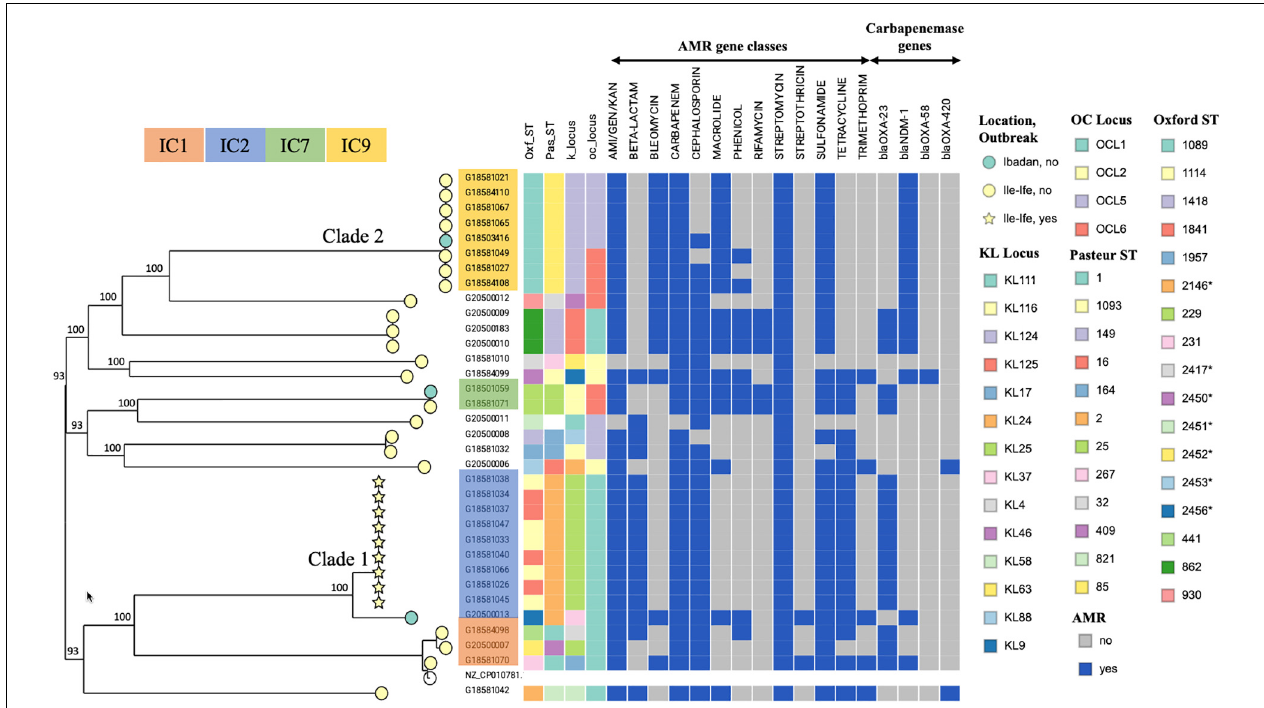
FIGURE 1 | Maximum likelihood phylogeny of A. baumannii isolates from OAUTHC, Ife, Osun State and UCH, Ibadan, Oyo State, Nigeria between 2017 and 2019. Sequence types, KL and OC types, classes of antimicrobials to which resistance is conferred by harbored genes, and carbapenem resistance genes are shown. Tree node colors represent isolate collection location; nodes in star shape represent the confirmed outbreak strains. Internal node labels show percentage bootstrap support for all bifurcations.